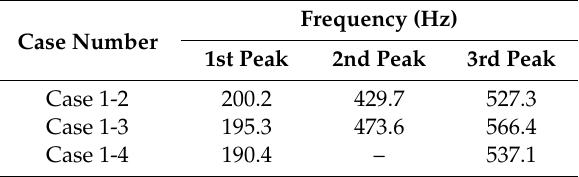
Table 3. Frequency values related to coherency losses between reference and every inspected